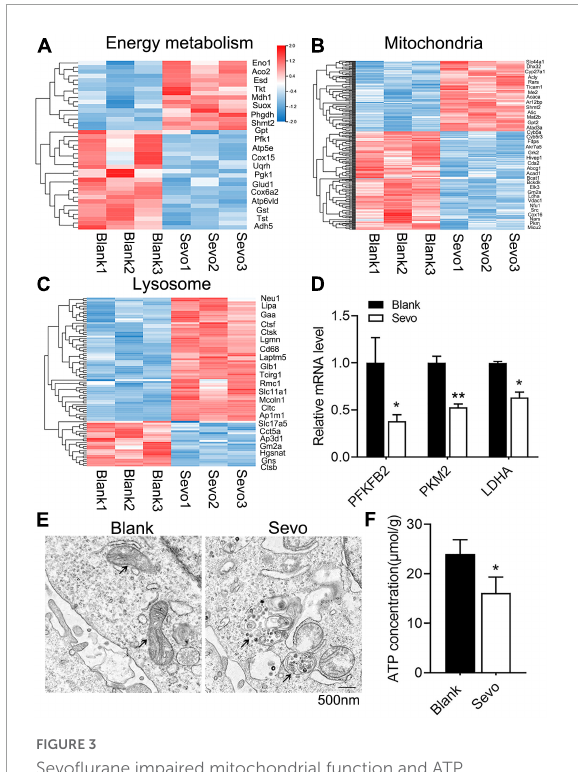
FIGURE3 Sevoflurane impaired mitochondrial function and ATP production. (A–C) Transcriptome analysis of the RNA-sequence data of BV-2 cell line. The heat map represents the cluster analysis of energy metabolism, mitochondria, and lysosome pathway-associated genes. Expression levels were measured as RPKM-normalized values. Each row represents a differentially expressed gene, while each column represents a sample. The blue and red color gradients indicate decreases and increases in transcript abundances, respectively. (D) qRT-PCR of BV-2 cell line shows the mRNA level of metabolism-related genes, including PFKFB2, PKM2, and LDHA. p(PFKFB2) = 0.019, p(PKM2) = 0.01, p(Ldha) = 0.024. N = 3. (E) TEM of BV-2 cell line, black arrowhead in left image indicates mitochondria, while black arrowhead in the right image indicates the gathered lysosome around the mitochondria. (F) ATP production of BV-2 cell line was determined by the ATP production detection kit. p = 0.039. N = 3. Scale bar, 500 nm. * P ≤ 0.05, ** P ≤